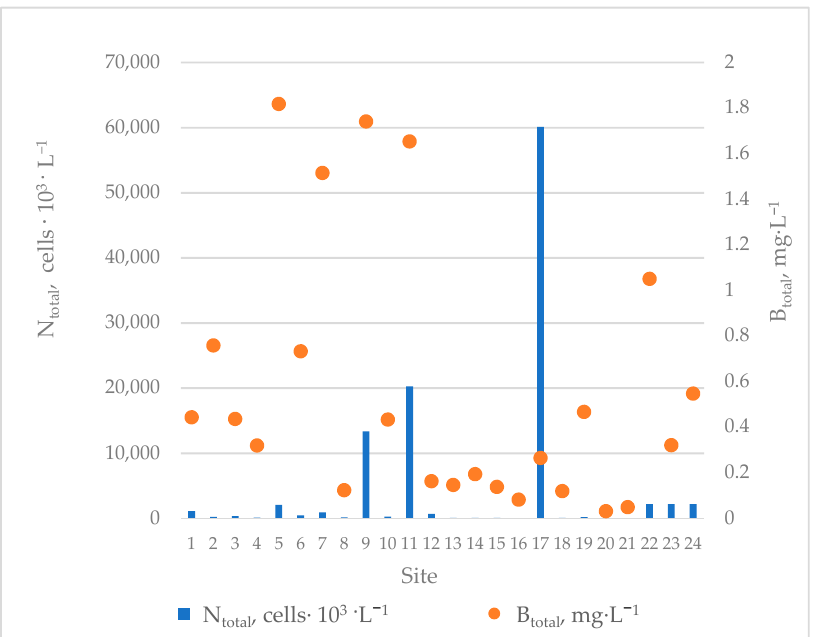
Figure 4. Abundance (N) and biomass (B) of phytoplankton in the Siversky Donets river basin (Ukrainian part).